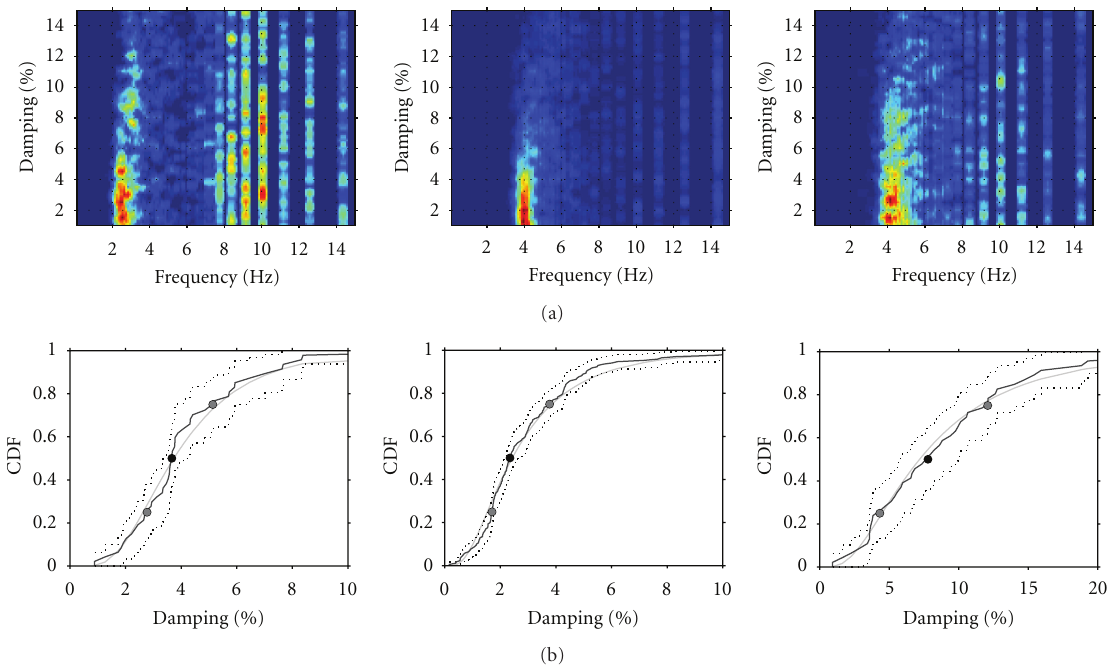
Figure 13: Same as Figure 12, but for sensor 13 (opposite of sensor 5, i.e., in the middle of the central arch on the right side of the bridge